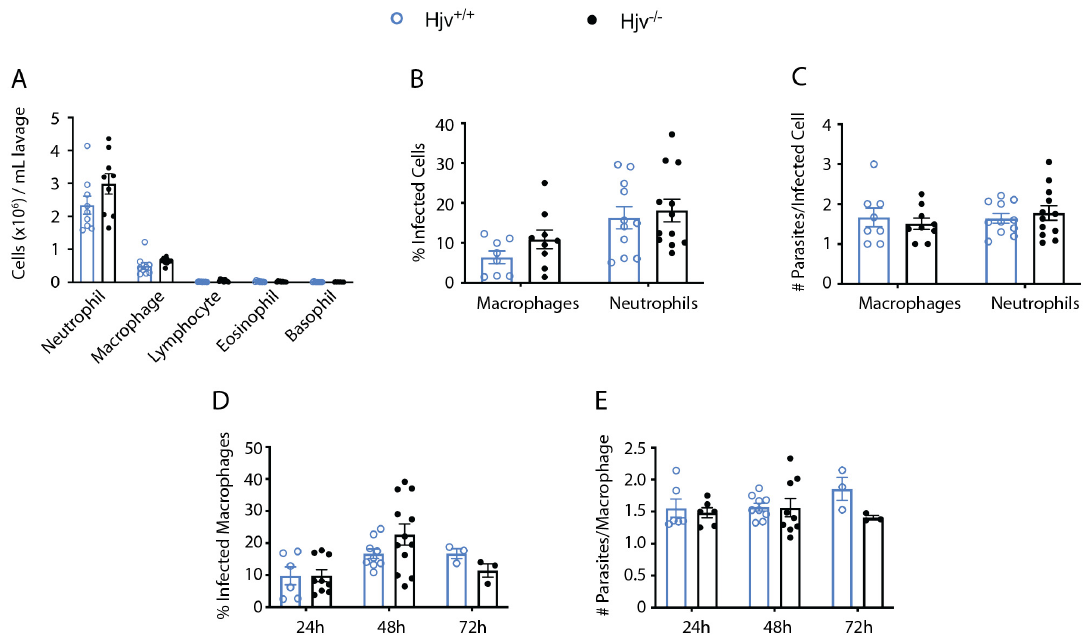
Figure 5. Analysis of intraperitoneal macrophages and neutrophils recovered post-infection. Hjv +/+ and Hjv − / − mice were injected intraperitoneally with 10 8 L. major stationary phase parasites. Then, 6 h post-infection, the peritoneum was lavaged, peritoneal cells were counted, and 50 µ L from the suspension was used for cytospin centrifugation. Cells were fixed onto slides and stained using Diff-Quik. Numbers of separated cell types are shown in ( A ). Percentage of infected macrophages and neutrophils ( B ), and number of parasites per infected cell ( C ) were assessed. ( D , E ) 10 5 cells following lavage were plated in 4-well chambers. Cells were cultured over 24, 48, and 72 h before removal of media, drying, and staining with Diff-Quik. Percentage of infected cells (macrophages) ( D ), and number of parasites per infected cell ( E ) were assessed. Data are presented as mean ±